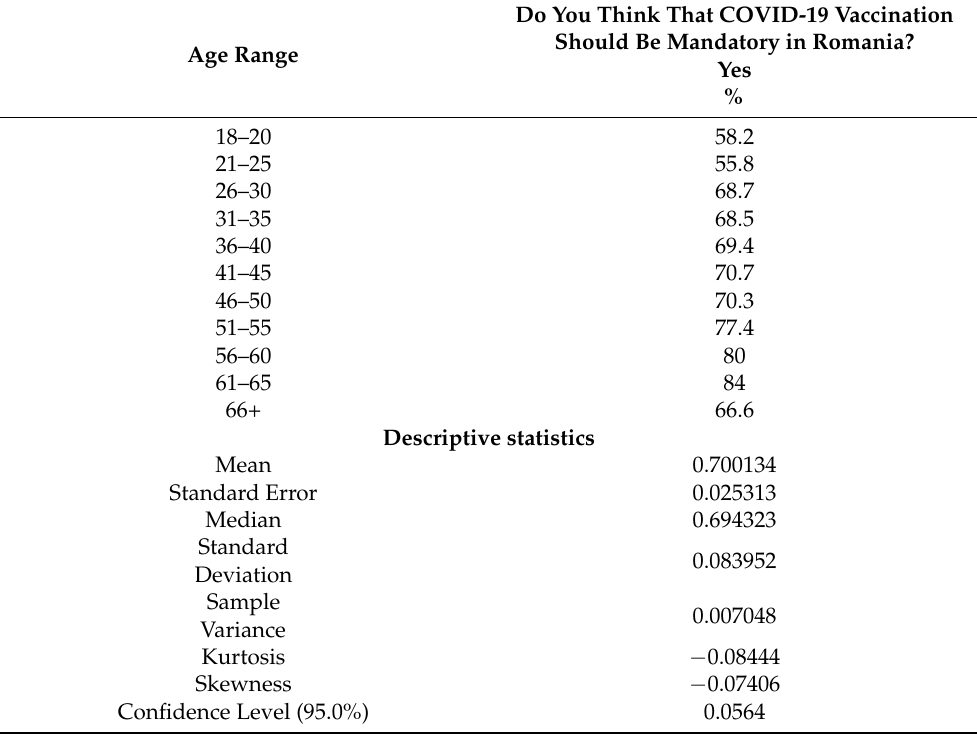
Table 6. Mandatory vaccination uptake rate.